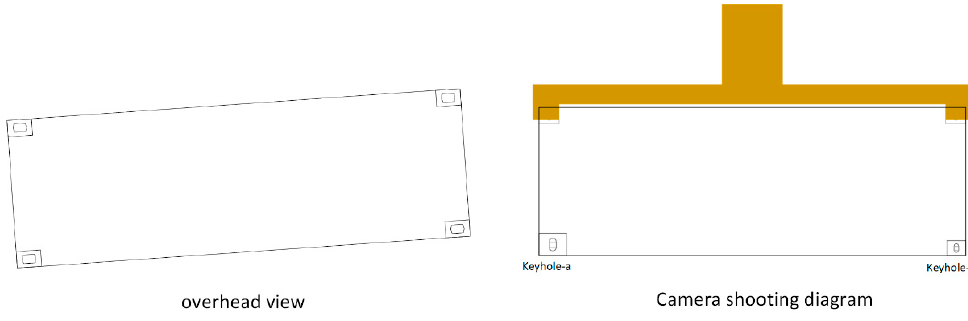
Figure 12. Container X direction offset.